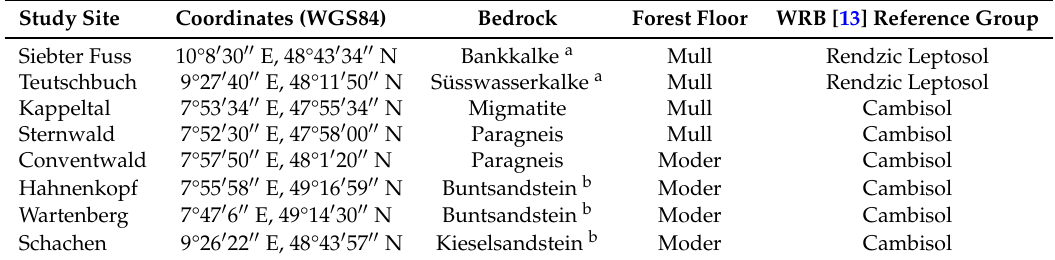
Table 1. Coordinates, underlying bedrock, forest floor type, and soil reference group for the eight study sites. Mull and moder are differentiated by the absence or development of an Oa horizon, respectively. Study Site Coordinates (WGS84) Bedrock Forest Floor WRB [13] Reference